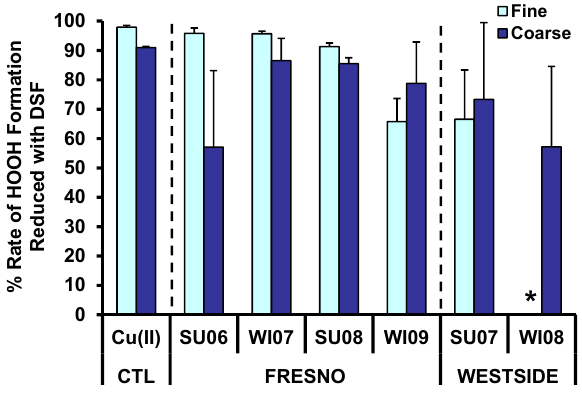
Fig. 5. Inhibitory effect of DSF on the initial rate of HOOH gen- eration in SLF with ascorbate for the Cu control and the SJV PM. Values are means ± SD. n = 3 for extractions without added DSF, and n = 2 for extractions with added DSF. The asterisk indicates that HOOH formation in this sample was not statistically different from zero.